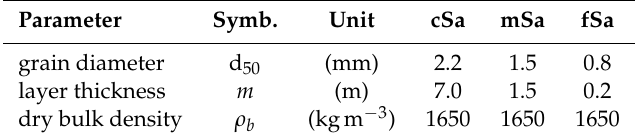
Table 1. Sediment fractions and parameters used in the large numerical